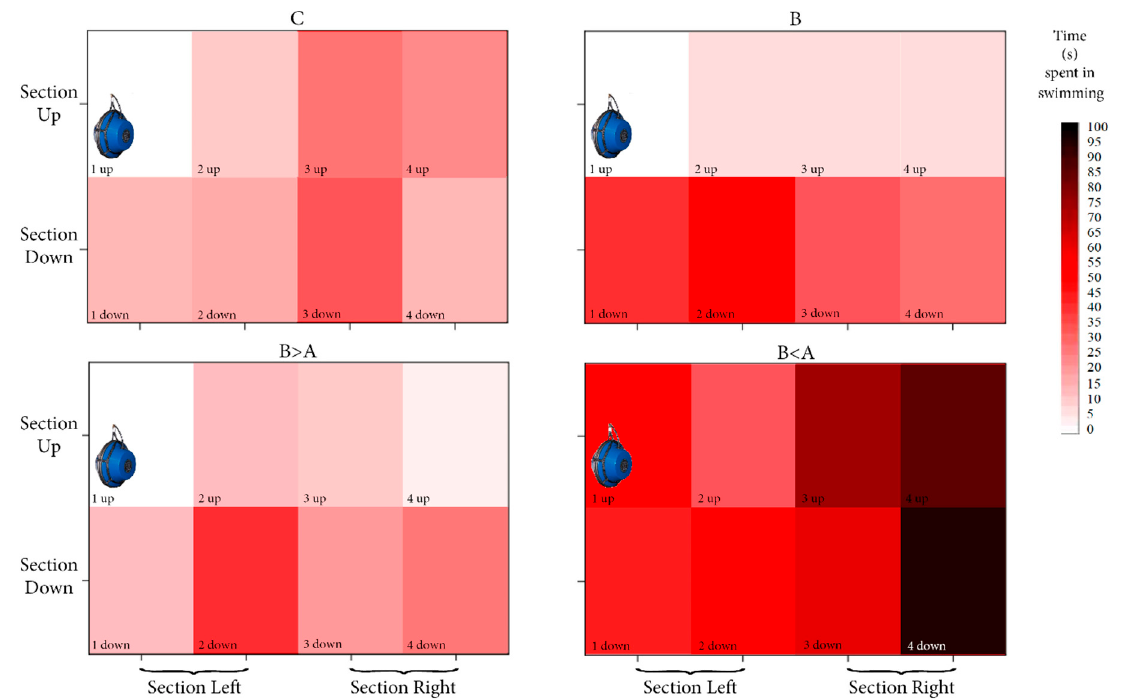
Figure 5. Cluster heatmap showing the spatial occupancy in terms of time spent in swimming (expressed in seconds) by the sharks among the aquarium cells. Section Up, constituted by 1, 2, 3, and 4 up cells. Section Down, constituted by 1, 2, 3, and 4 down cells. Section Left, constituted by 1–2 up and 1–2 down cells. Section Right, constituted by 3–4 up and 3–4 down cells. On the left wall, the location of the underwater sound speaker is presented. C, control condition; B: biological condition; B > A, biological >anthropogenic condition; B < A, biological <anthropogenic condition.